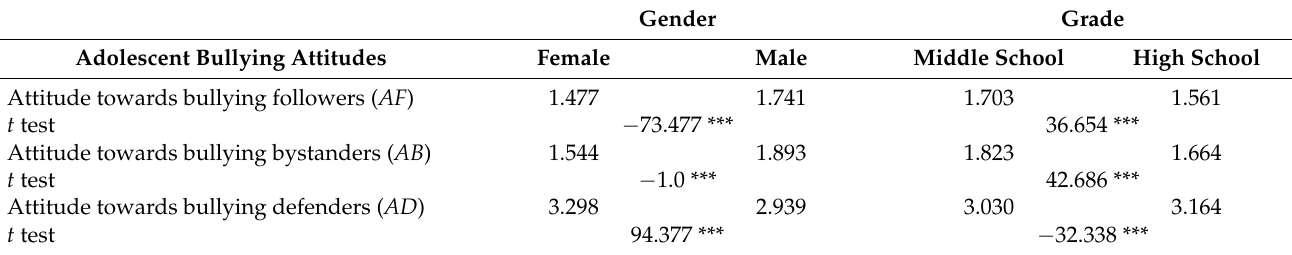
Table 3. Differences in adolescent bullying attitudes after matching, by gender and